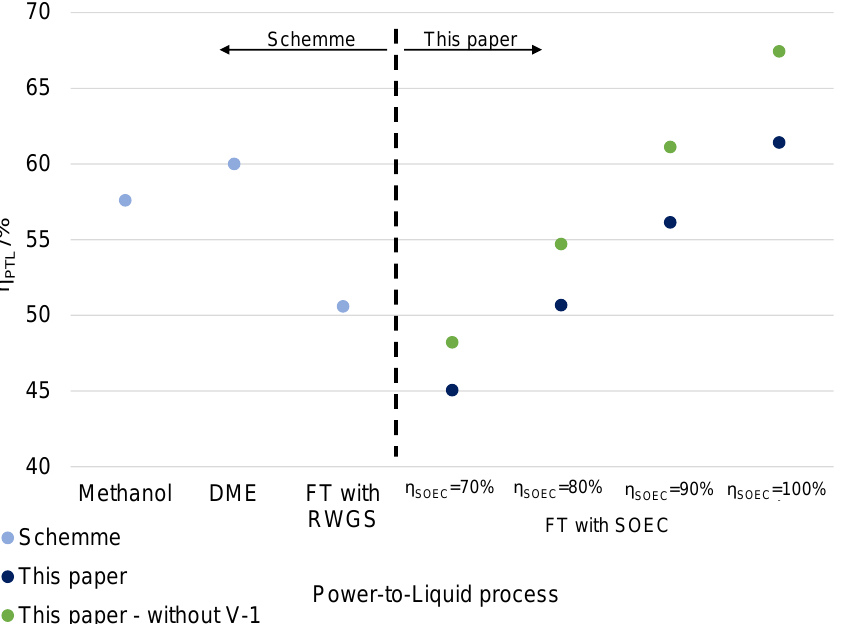
Figure 15. Comparison of the PtL efficiency of the developed fuel synthesis with those of alternative PtL processes (η PTl of methanol, DME, and FT with the RWGS process according to Schemme [54] ).